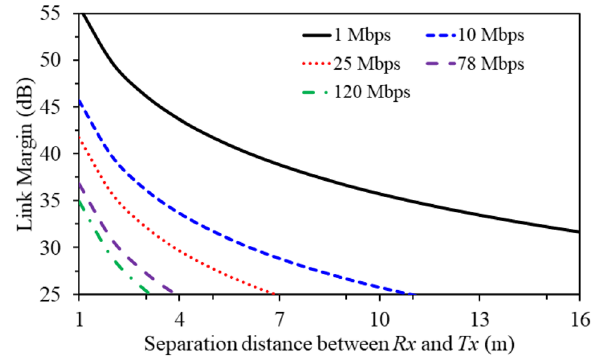
Figure 13. Link margin (in dB) of the proposed wideband implantable MIMO antenna (distance between the transmitter ( Tx ) and receiver ( Rx ) is varied).